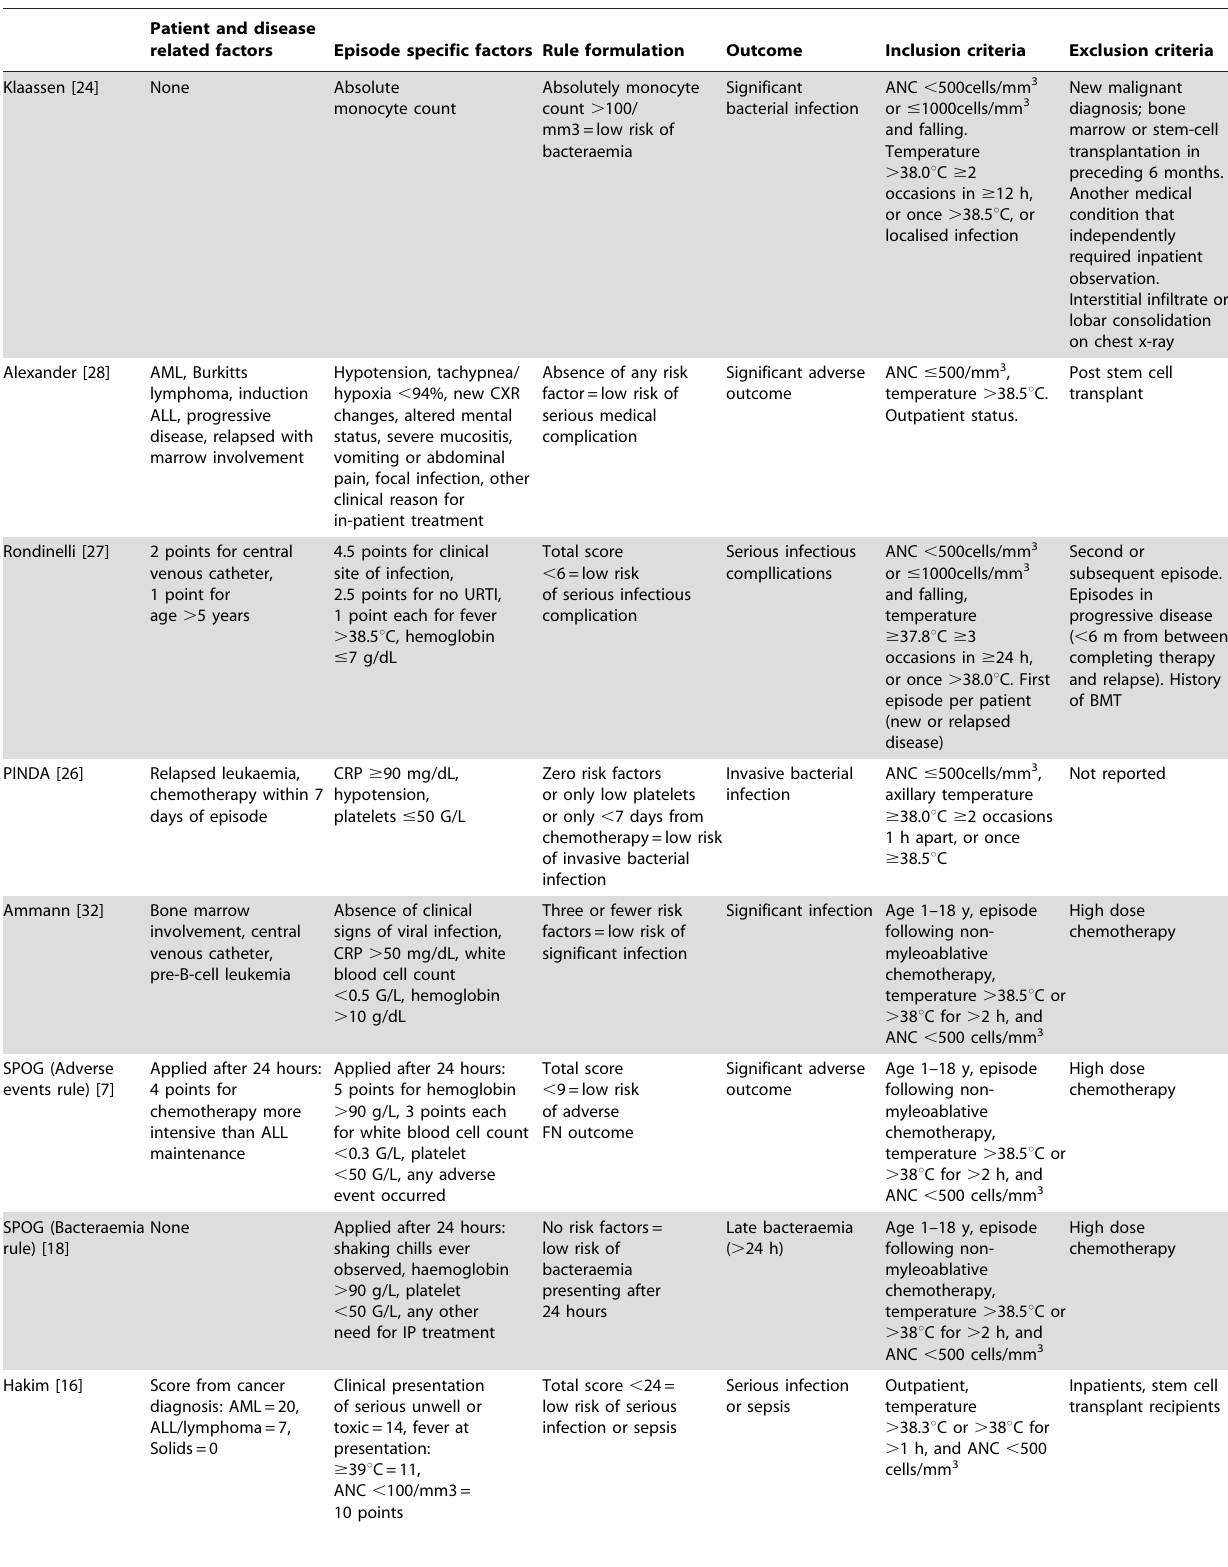
Table 1. Clinical decision rules